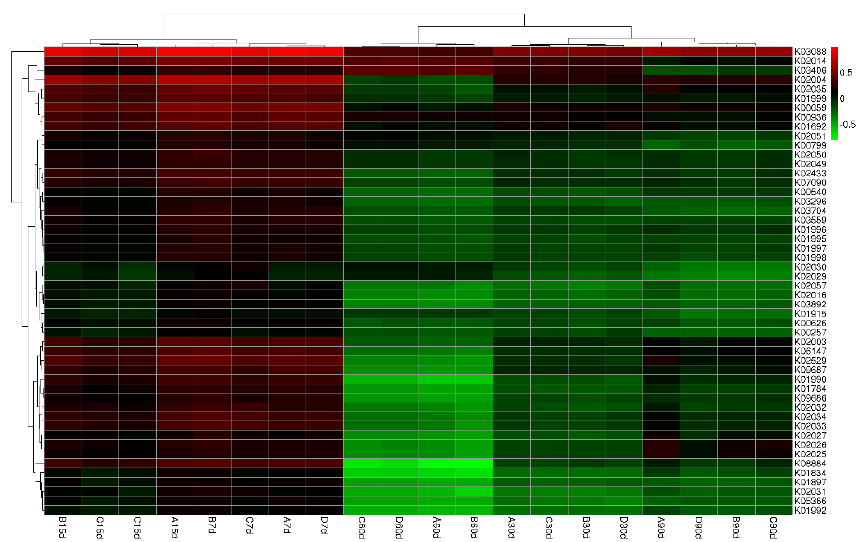
Figure 9. Heatmap of bacterial community abundance for KEGG homologous gene clusters (KO), derived from a cluster analysis. The color gradient from green to red indicates increasing similarity. Each cell depicts the similarity for two soil samples in the matrix. (A: 0 mg kg −1 ; B: 10 mg kg −1 ; C: 100 mg kg −1 ; D: 1000 mg kg −1 ; 7, 15, 30, 60, and 90 d mean 7, 15, 30, 60, and 90 days, respectively; K03088: RNA polymerase sigma-70 factor, ECF subfamily; K02014: iron complex outer membrane receptor protein; K03406: methyl-accepting chemotaxis protein; K02004: None; K02035: peptide/nickel